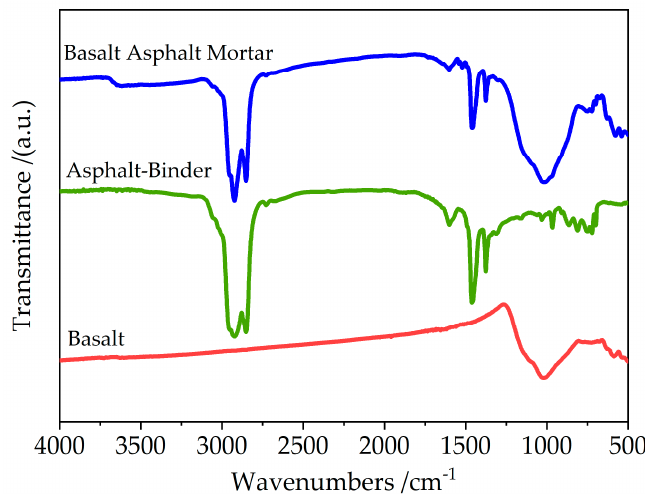
Figure 6. Infrared spectra of the asphalt-binder, basalt, and mortar.